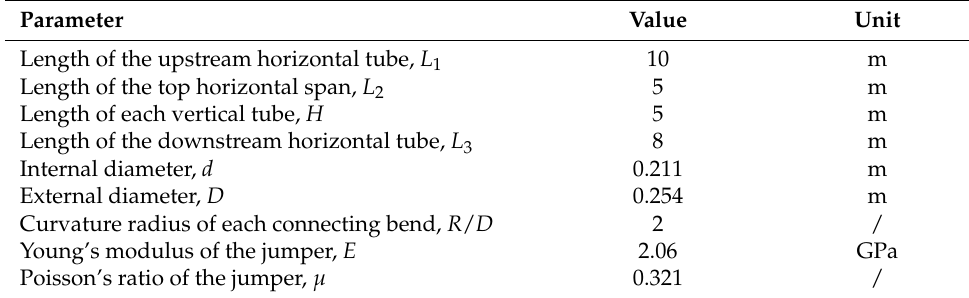
Figure 1. Schematic of the reversed U-shaped jumper with the geometric definition and boundary conditions, where A-A, B-B, C-C and D-D are the cross-sections at the midspans of four bends, and Probe 1, Probe 2 and Probe 3 are three probes in the midspan of three key tubes. Table 1. Key parameters of the reversed U-shaped jumper.